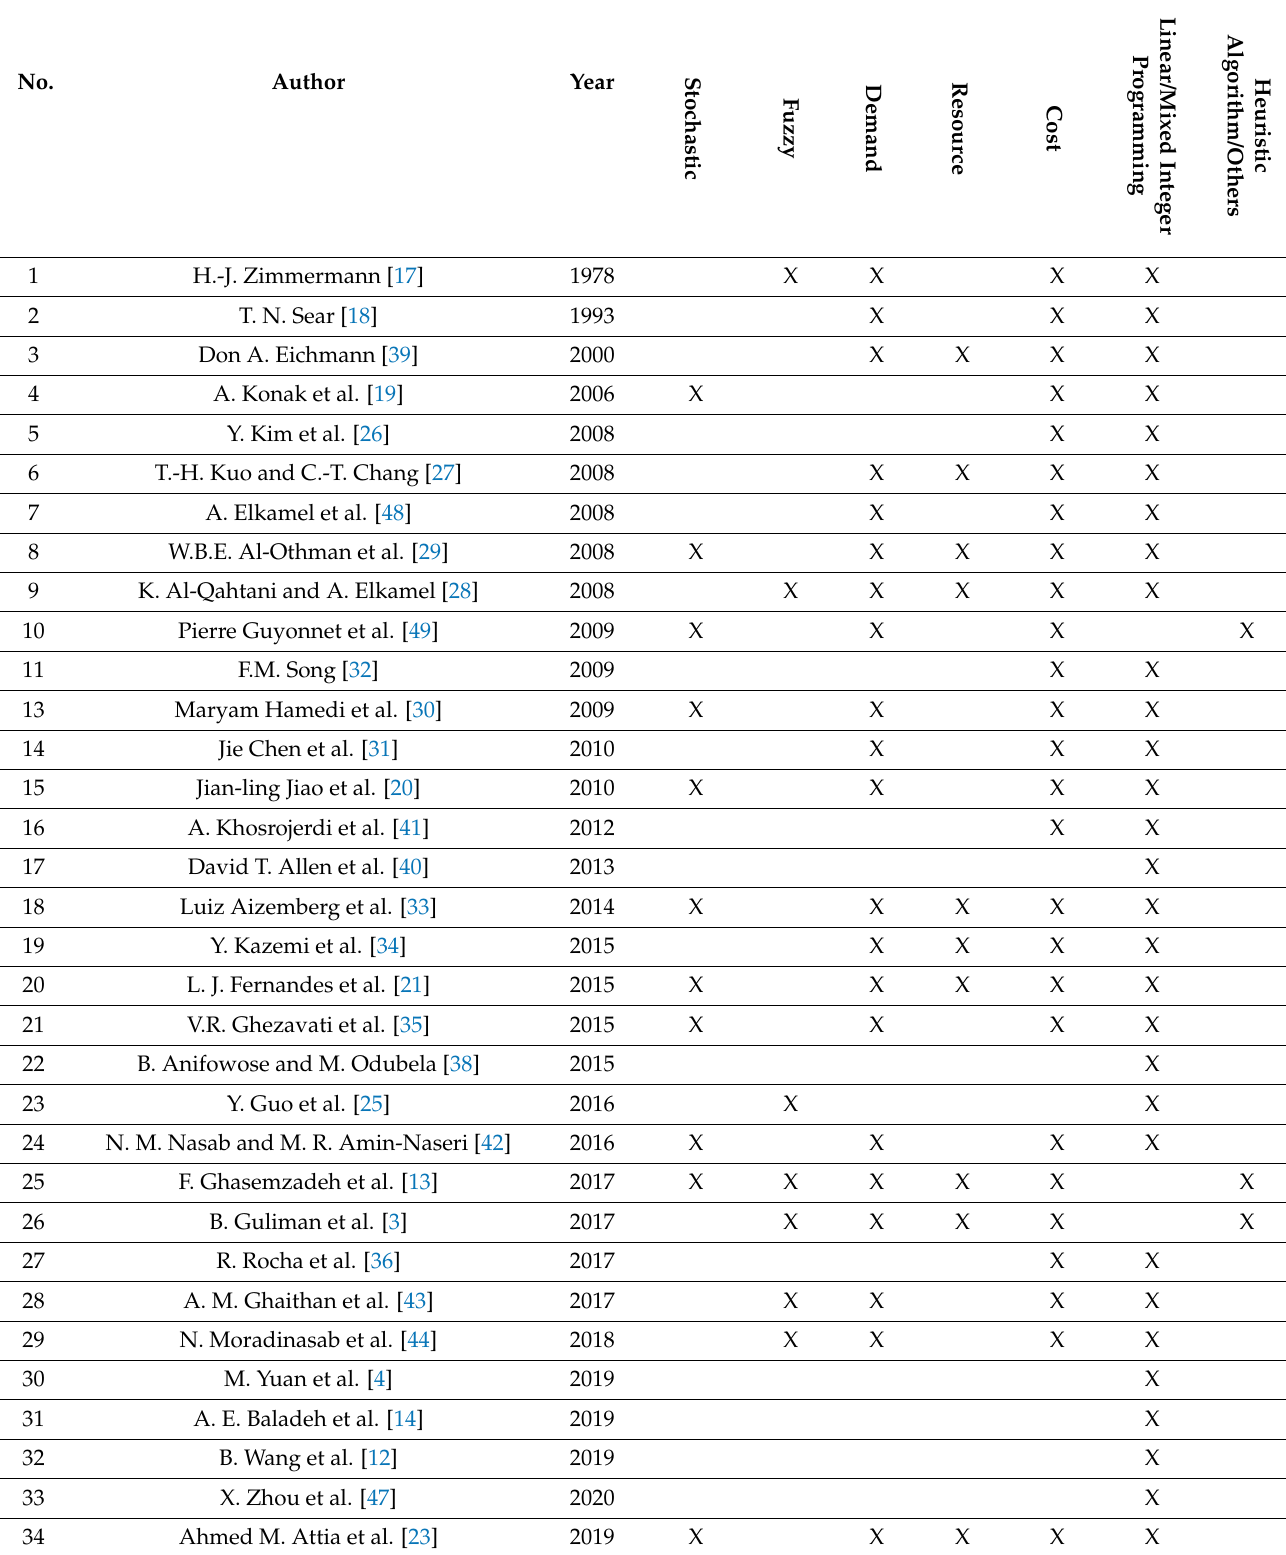
Table 2. Related research